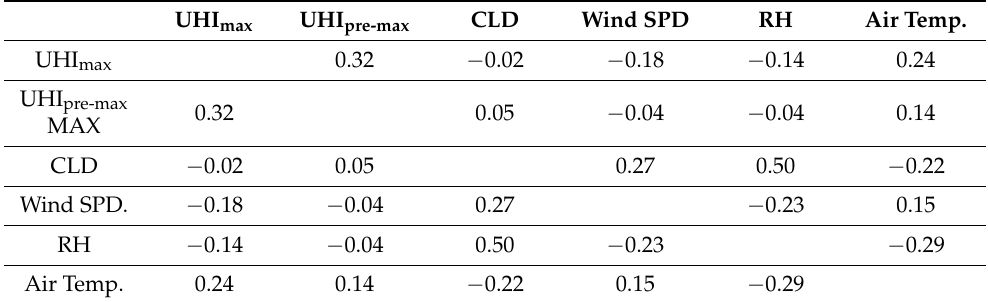
Table 3. Partial correlation analysis of UHI parameters and meteorological elements (summer, 2002–2012, incomplete observations were excluded).